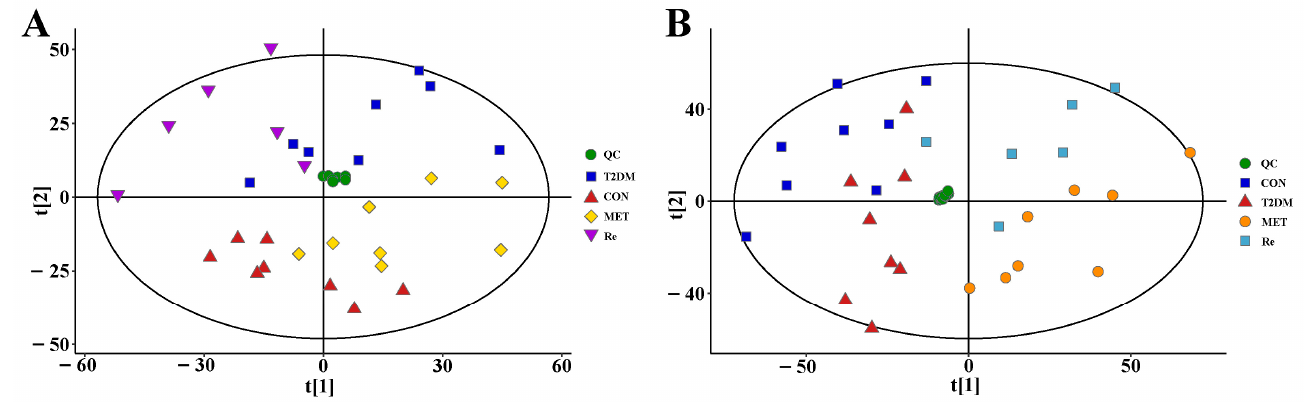
Figure 2. The PCA score plots of all samples from serum ( A ) and urine ( B ).